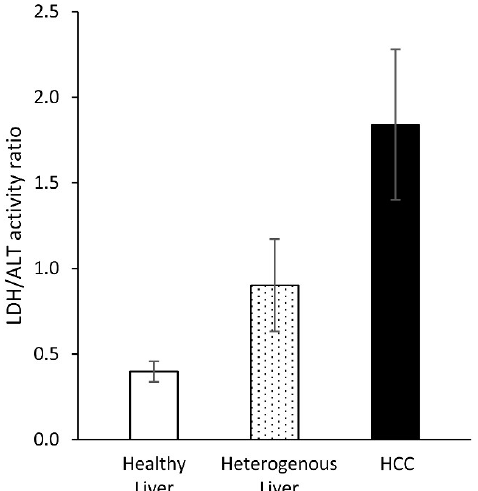
Figure 3. The LDH to ALT activities ratio in PCLS from normal liver, heterogeneous liver, and HCC tumors in the liver. Normal livers were obtained from healthy mice (white bar). Heterogeneous livers (dotted bar) and HCC tumors of the liver (black bars) were obtained from aged MDR2-KO mice which typically show progressive liver disease [29]. The enzymatic activity was calculated following an injection of hyperpolarized [1- 13 C]pyruvate. LDH and ALT activities were determined by the production rate of hyperpolarized [1- 13 C]lactate and [1- 13 C]alanine, respectively. The error bars mark the standard deviation between animals within each group ( n = 3 for all groups). The significance of the differences between the groups was assessed with one tailed t -tests with the following results: Healthy livers vs. Heterogeneous livers, p = 0.031; Heterogeneous livers vs. HCC tumors, p = 0.033, Healthy livers vs. HCC tumors, p = 0.006. Table 1. Parameters used for enzymatic rate calculations per animal per injection of hyperpolarized [1- 13 C]pyruvate.